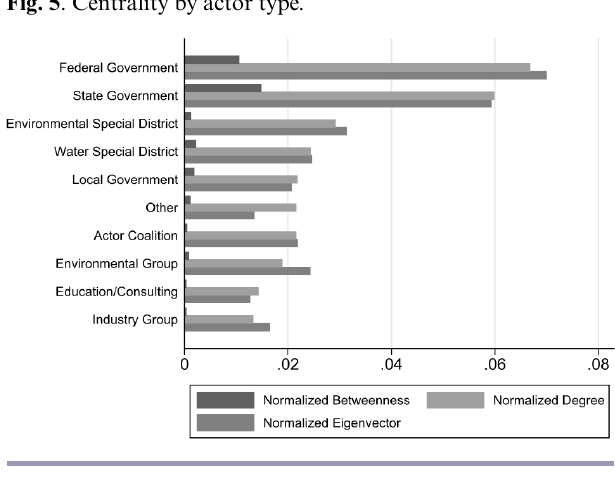
Fig. 5 . Centrality by actor type.